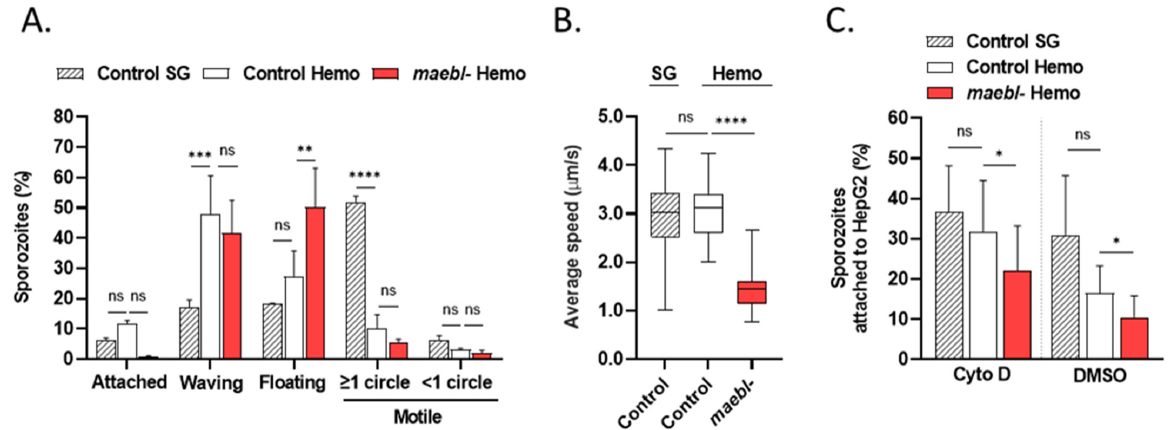
Figure 4. Analysis of maebl - sporozoites gliding motility and adhesive properties. ( A , B ) Gliding motility of Control salivary gland (SG) and hemolymph (Hemo) sporozoites, and maebl - Hemo sporozoites. Sporozoites were allowed to glide in medium supplemented with FBS at 37 ◦ C. Bright- field images were acquired every second for 1 min using an inverted epifluorescence microscope. ( A ) Gliding behaviors of maebl - sporozoites. Sporozoites (Control SG n = 316, Control Hemo n = 296, and maebl - Hemo n = 839) were classified according to their motility behaviors. Bars indicate the mean of two independent experiments + SD. Statistical analysis was performed using two-way ANOVA (Tukey’s multiple comparisons test). ( B ) Gliding speed of maebl - sporozoites. Box plots showing the median, maximum, minimum, and the 25th and 75th percentiles of the average speed of individual sporozoites (Control SG n = 20, Control Hemo n = 12, and maebl - Hemo n = 22). Data were pooled from two independent experiments. Statistical analysis was performed using one-way ANOVA (Tukey’s multiple comparisons test). ( C ) Adhesion of Control SG and Hemo sporozoites, and maebl - Hemo sporozoites to HepG2 cells. Sporozoites were added on top of cells, in the presence of cytochalasin D (Cyto D) or DMSO. After 30 min incubation at 37 ◦ C, the supernatant was removed to quantify the number of unattached sporozoites. After trypsinization, the number of extracellular parasites (attached sporozoites) was quantified. Quantification of sporozoites was performed by flow cytometry. The high levels of autofluorescence of HepG2 cells precluded the quantification of intracellular sporozoites. The graph shows the mean of three independent experiments performed at least in duplicate + SD. Statistical analysis was performed with repeated measures one-way ANOVA (Tukey‘s multiple comparisons test). ns, non-significant; * p < 0.05; ** p < 0.01; *** p <